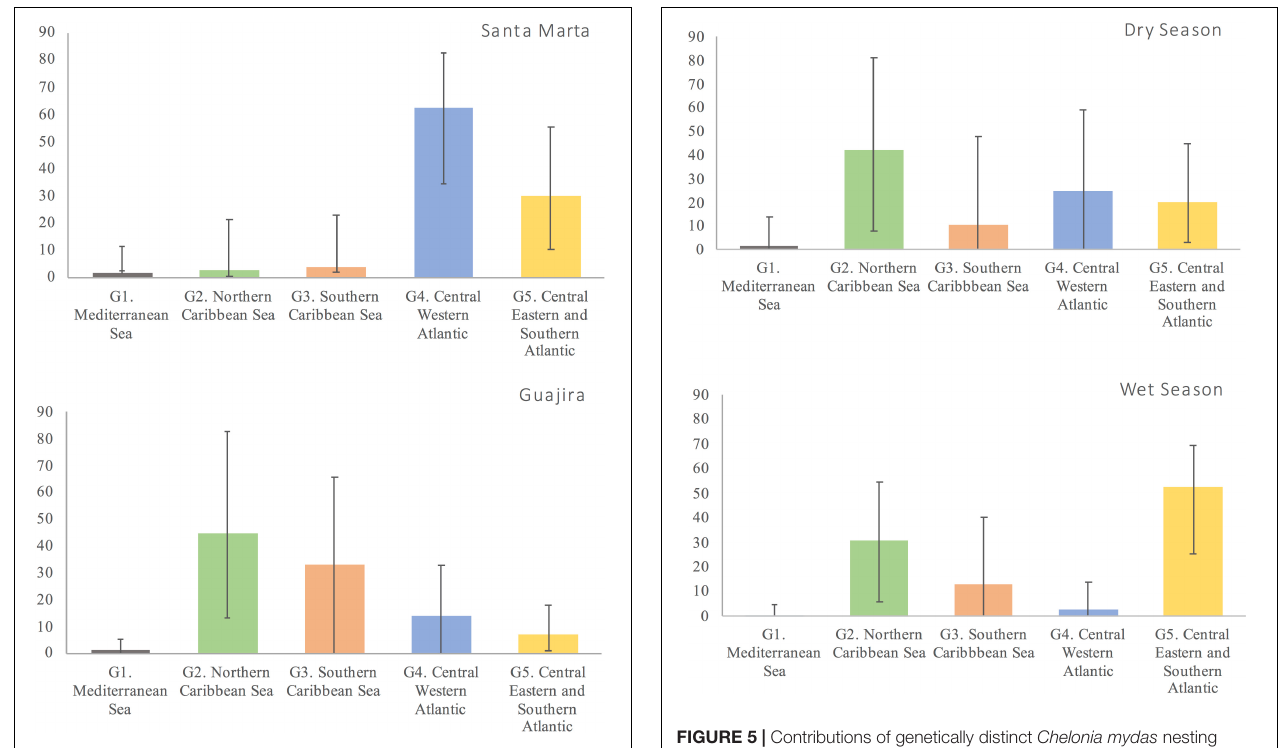
FIGURE 4 | Contributions of genetically distinct Chelonia mydas nesting rookery (NR) groups in the Atlantic to the mixed stocks in northeastern Colombia foraging grounds (FGs) “Santa Marta” and “La Guajira,” inferred with Bayesian mixed stock analysis (Bolker et al., 2007).